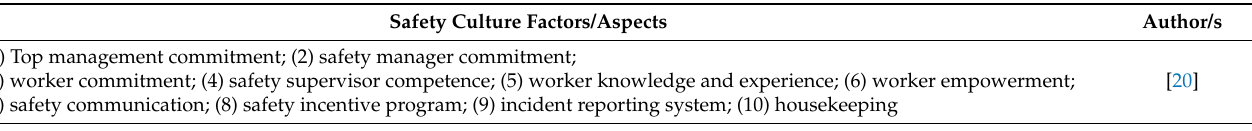
Table 3. Safety culture